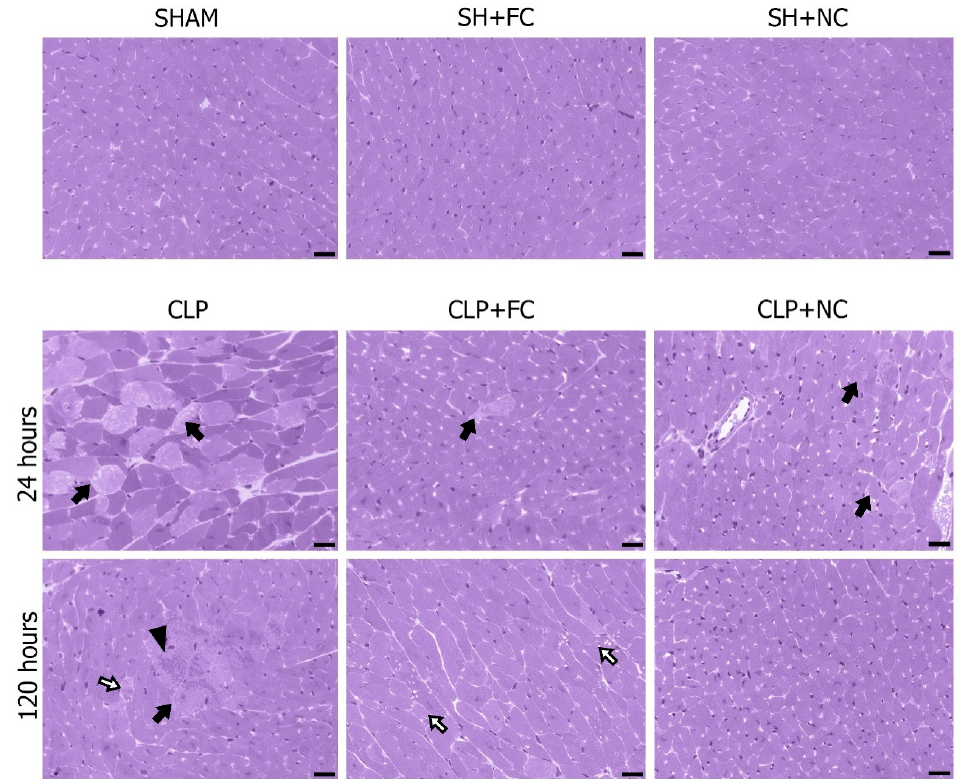
Figure 2. Histopathology of myocardial tissue from mice subjected to cecal ligation and puncture (CLP) sepsis. The myocardium of the sham-operated animals without SHAM treatment and treated with free curcumin (SH + FC) or nanocurcumin (SH + NC) after 120 h did not show any histopathological changes. Analysis of the myocardium in the septic group shows the presence of accentuated and diffuse myocytolysis (black arrow) at 24 h, and at 120 h, foci of cytoplasmic vacuoles (white arrow), and multifocal myocytolysis (black arrow) associated with bands of contracture (arrowhead). In the septic group treated with free curcumin (CLP + FC), at 24 h the presence of mild focal myocytolysis is noted (black arrow); at 120 h, cytoplasmic vacuole foci are observed (white arrow). In the septic group treated with nanocurcumin (CLP + NC), at 24 h it is possible to observe mild focal myocytolysis (black arrow); at 120 h it is possible to notice that the cardiac tissue is preserved. Photomicrographs were obtained using a 40× objective (50 μ m).